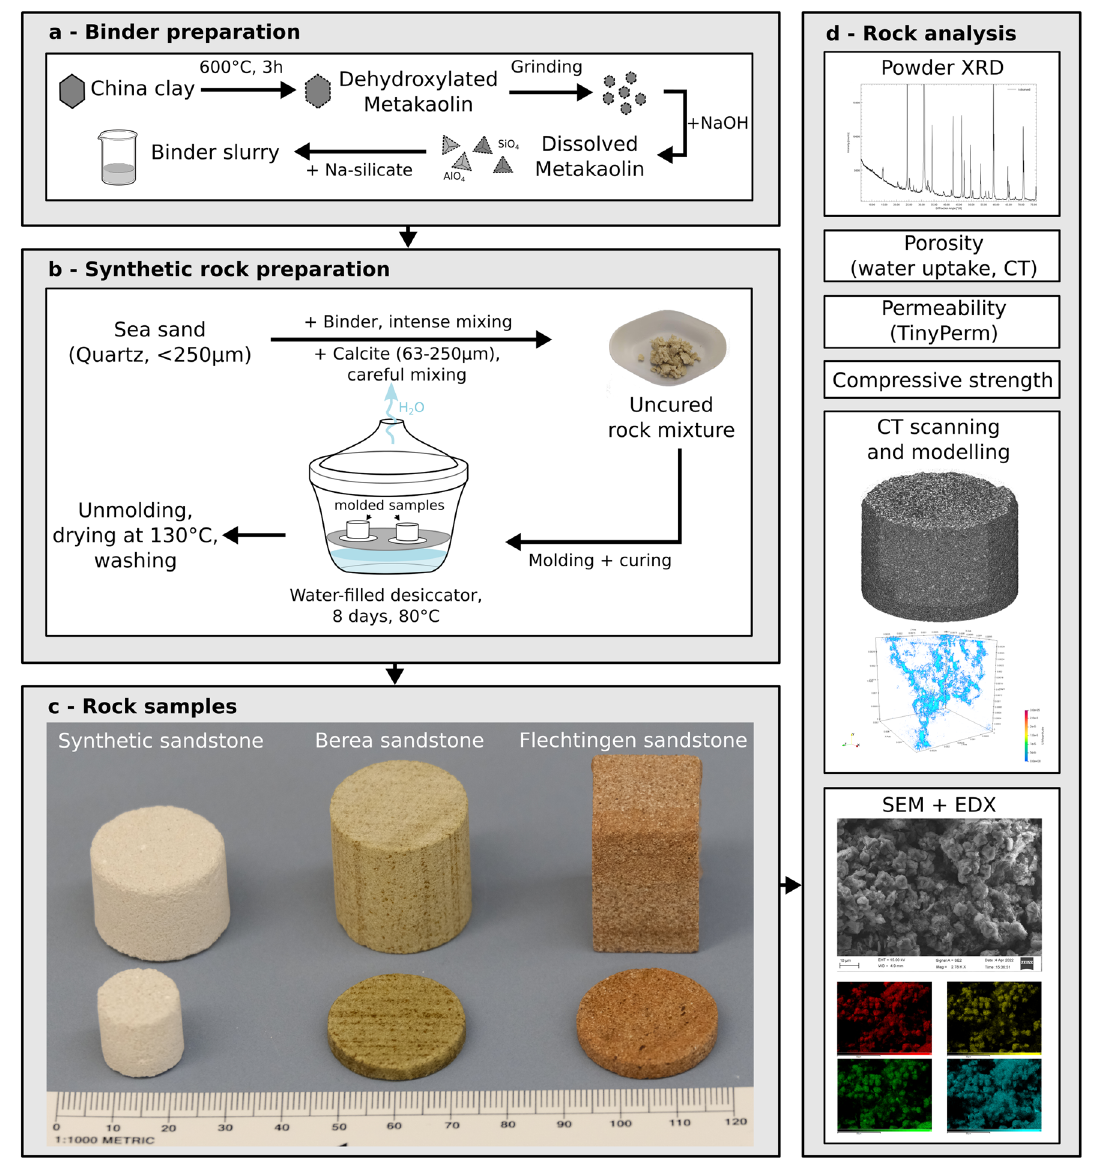
Flechtingen sandstone. d Overview of analytical methods used to study the synthetic